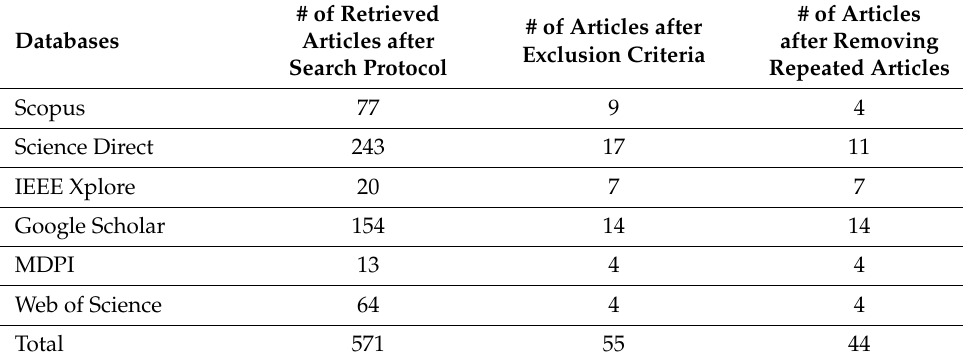
Table 1. Distribution of articles among various